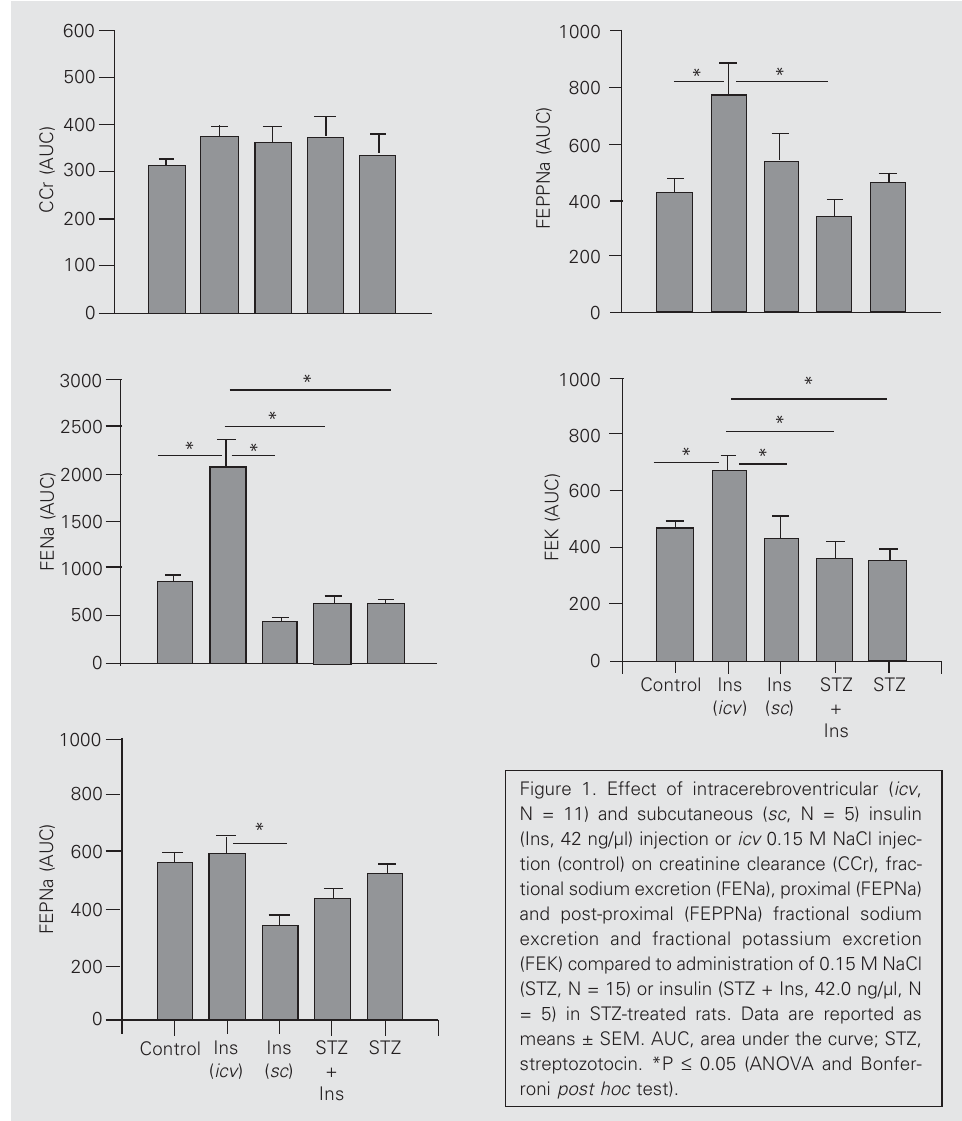
Figure 1. Effect of intracerebroventricular ( icv , N = 11) and subcutaneous ( sc , N = 5) insulin (Ins, 42 ng/µl) injection or icv 0.15 M NaCl injec- tion (control) on creatinine clearance (CCr), frac- tional sodium excretion (FENa), proximal (FEPNa) and post-proximal (FEPPNa) fractional sodium excretion and fractional potassium excretion (FEK) compared to administration of 0.15 M NaCl (STZ, N = 15) or insulin (STZ + Ins, 42.0 ng/µl, N = 5) in STZ-treated rats. Data are reported as means ± SEM. AUC, area under the curve; STZ, streptozotocin. *P ≤ 0.05 (ANOVA and Bonfer- roni post hoc